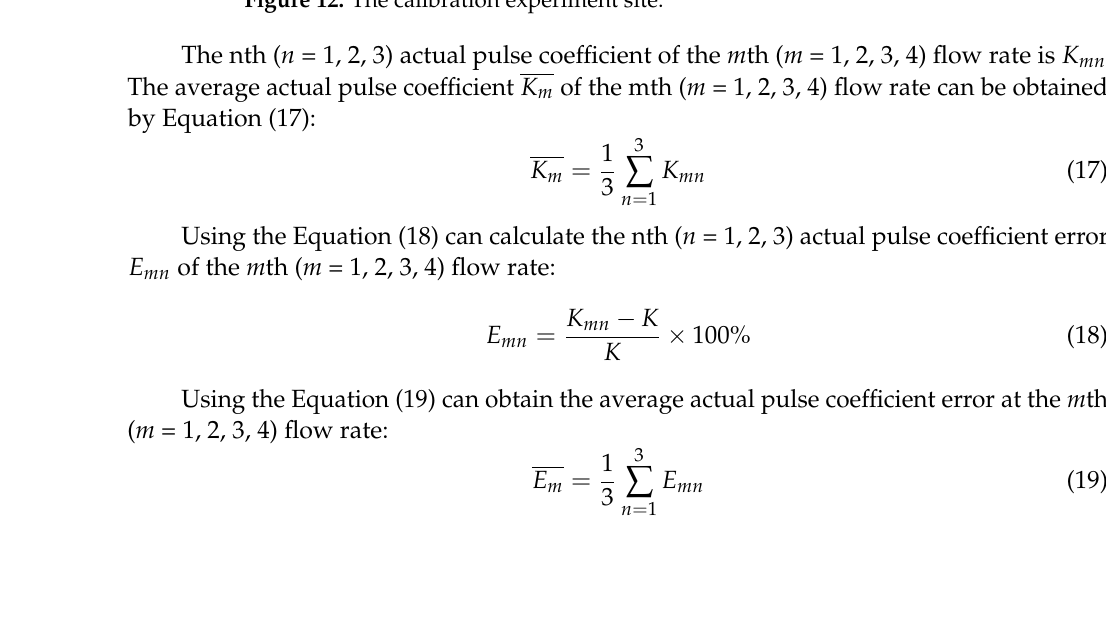
Figure 12. The calibration experiment site.